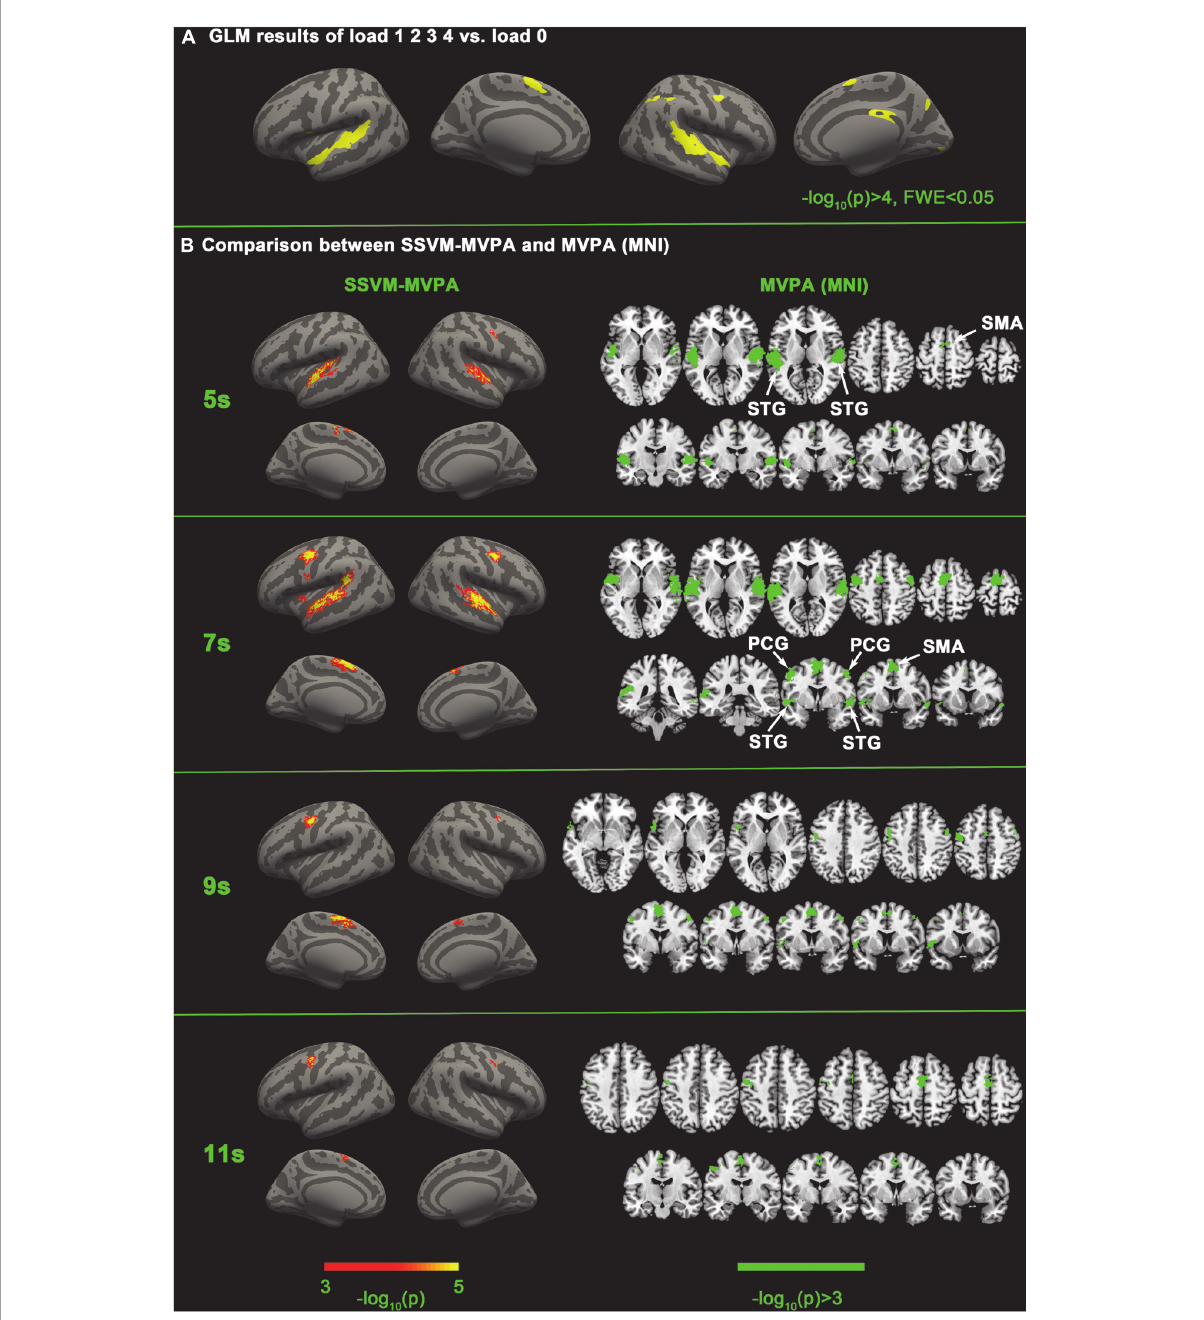
FIGURE4 GLM results of load 1 2 3 4 vs. load 0 and comparison between SSVM-MVPA and volume space-based MVPA. (A) Traditional contrast analysis between the experimental conditions and the baseline condition. (B) Comparison between SSVM-MVPA and MVPA (MNI). The figures of MVPA (MNI) are the same as Figure 3